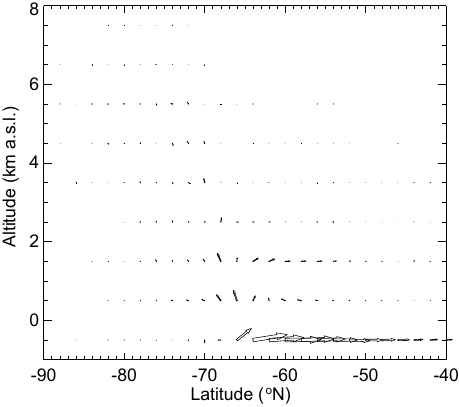
Figure A5. Two-dimensional vectors weighted by number of points at each pixel. Trajectories were calculated from the 10-day forward trajectories beginning at the ship location throughout the voyage. The rising air of the polar front is clearly visible, however the overwhelming flow is found to ascend slightly within the boundary layer, above the layer closest to the surface, then travel north.